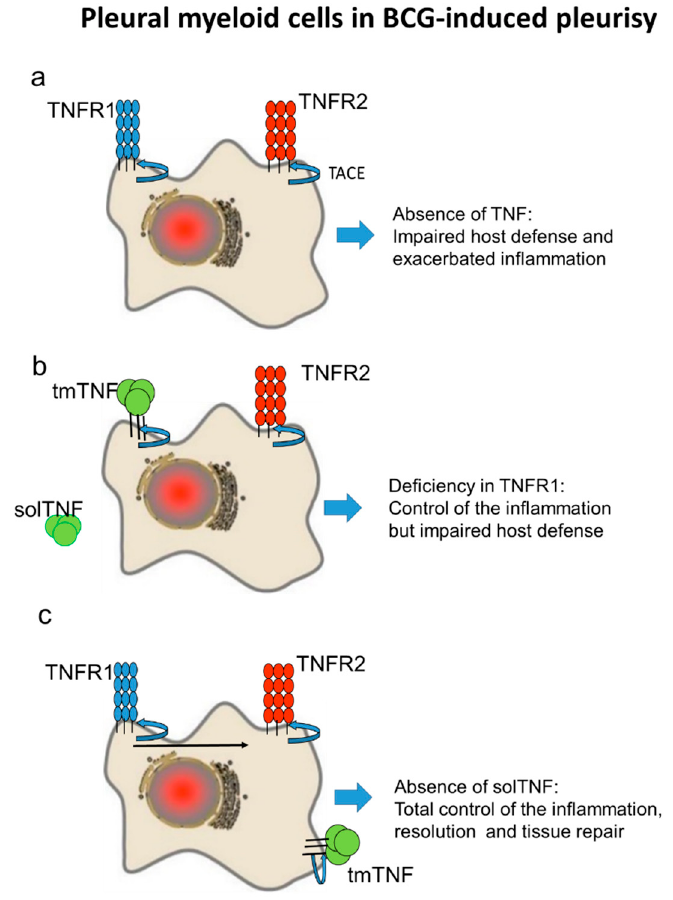
Figure 5. The schematic representation of myeloid cells expressing TNF and TNF receptors involved in the control of the inflammation after BCG-induced pleurisy. ( a ) The absence of TNF compromises host defense mechanisms and results in the exacerbated inflammation in the pleural cavity ( b ) TNF and TNFR2 control the pleural cavity inflammation but the absence of TNFR1 may compromise host immunity. ( c ) In the absence of solTNF, tmTNF controls the inflammation and immunity. TACE is represented as the membrane metalloprotease cleaving TNF and TNF receptors.